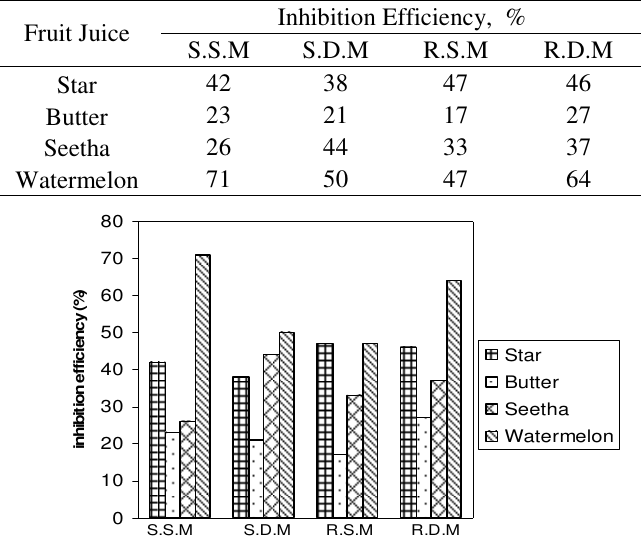
Figure 2. Inhibition of calcium phosphate mineralization by fruit juice. Table 3. Inhibition of calcium carbonate mineralization by fruit juice.